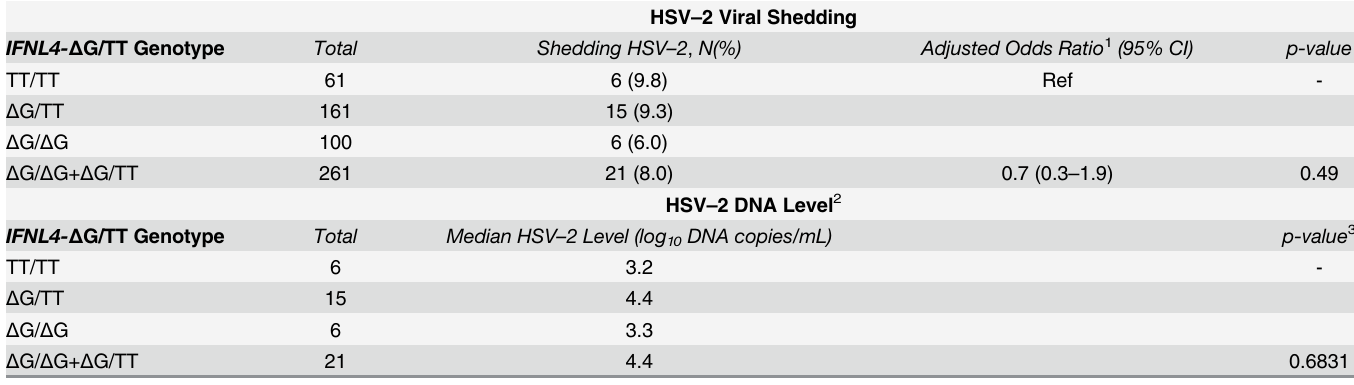
HSV – 2 Viral Shedding